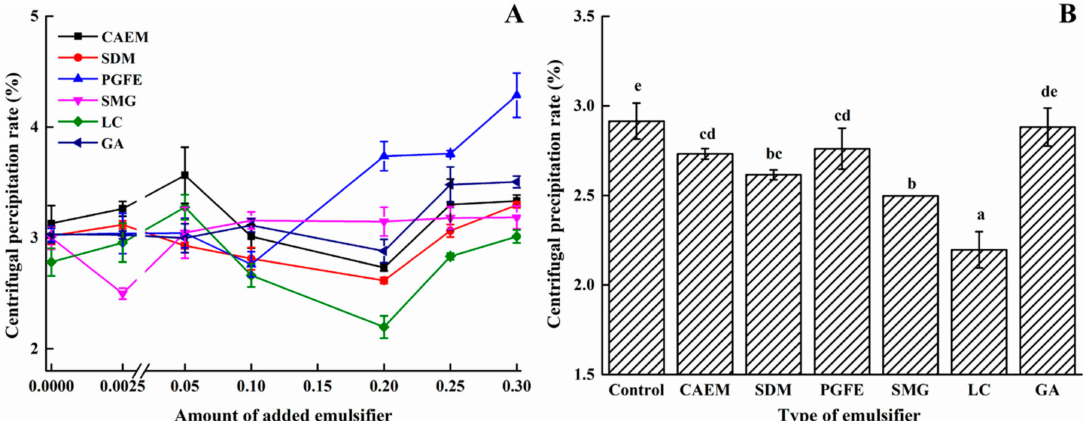
Figure 1. The centrifugal precipitation rate (CPR) of the emulsions with di ff erent emulsifier contents ( A ) and the CPR values of the six emulsifiers at their respective suitable addition levels ( B